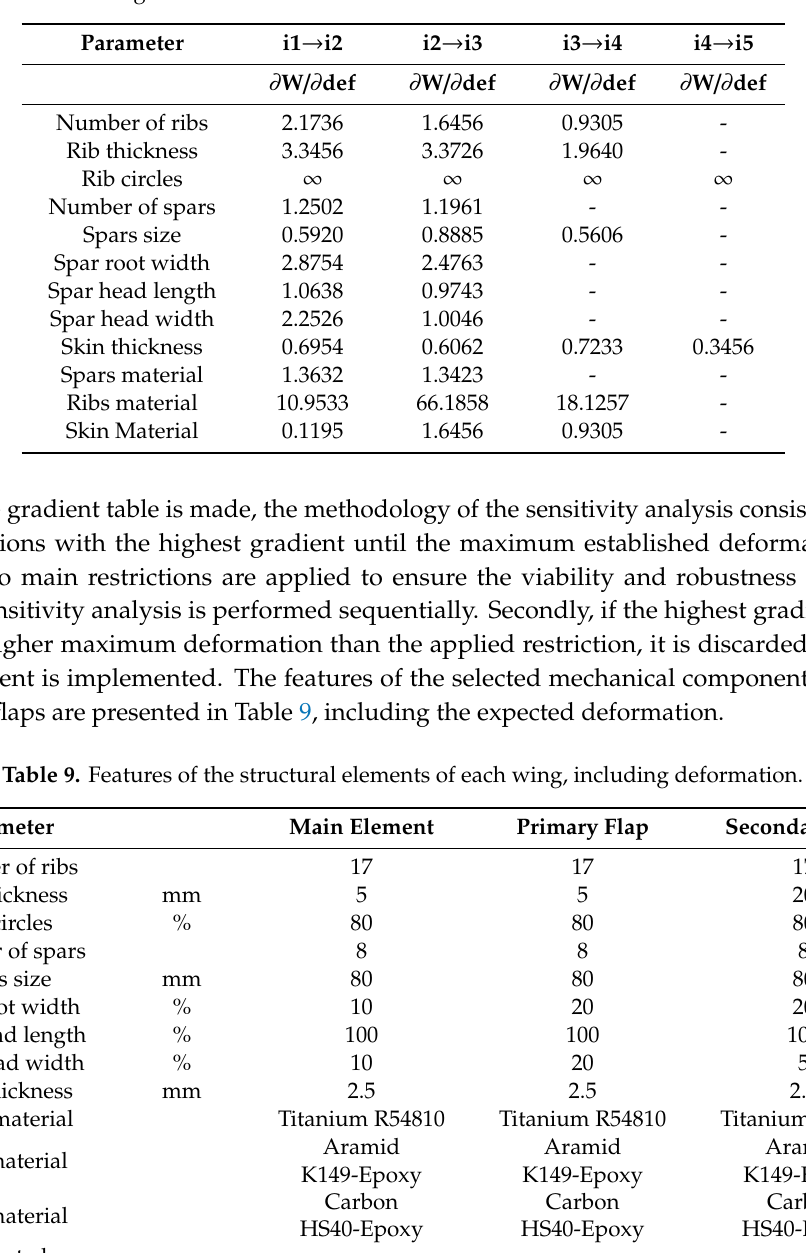
Table 8. Weight-deformation variation gradient of the entire wing according to the sequential combination in each degree of freedom.